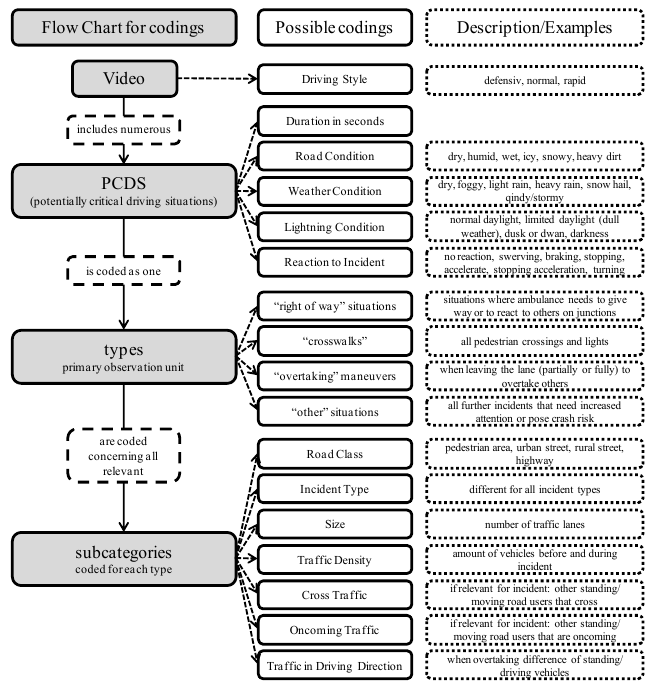
Figure 1. Flow chart of the coding